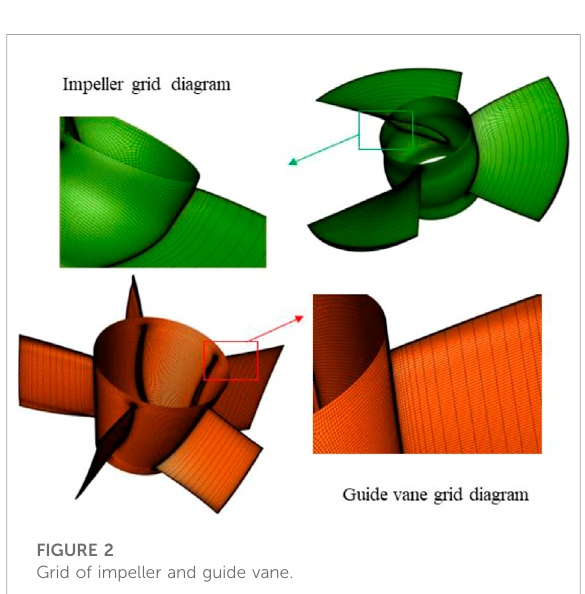
Grid of impeller and guide